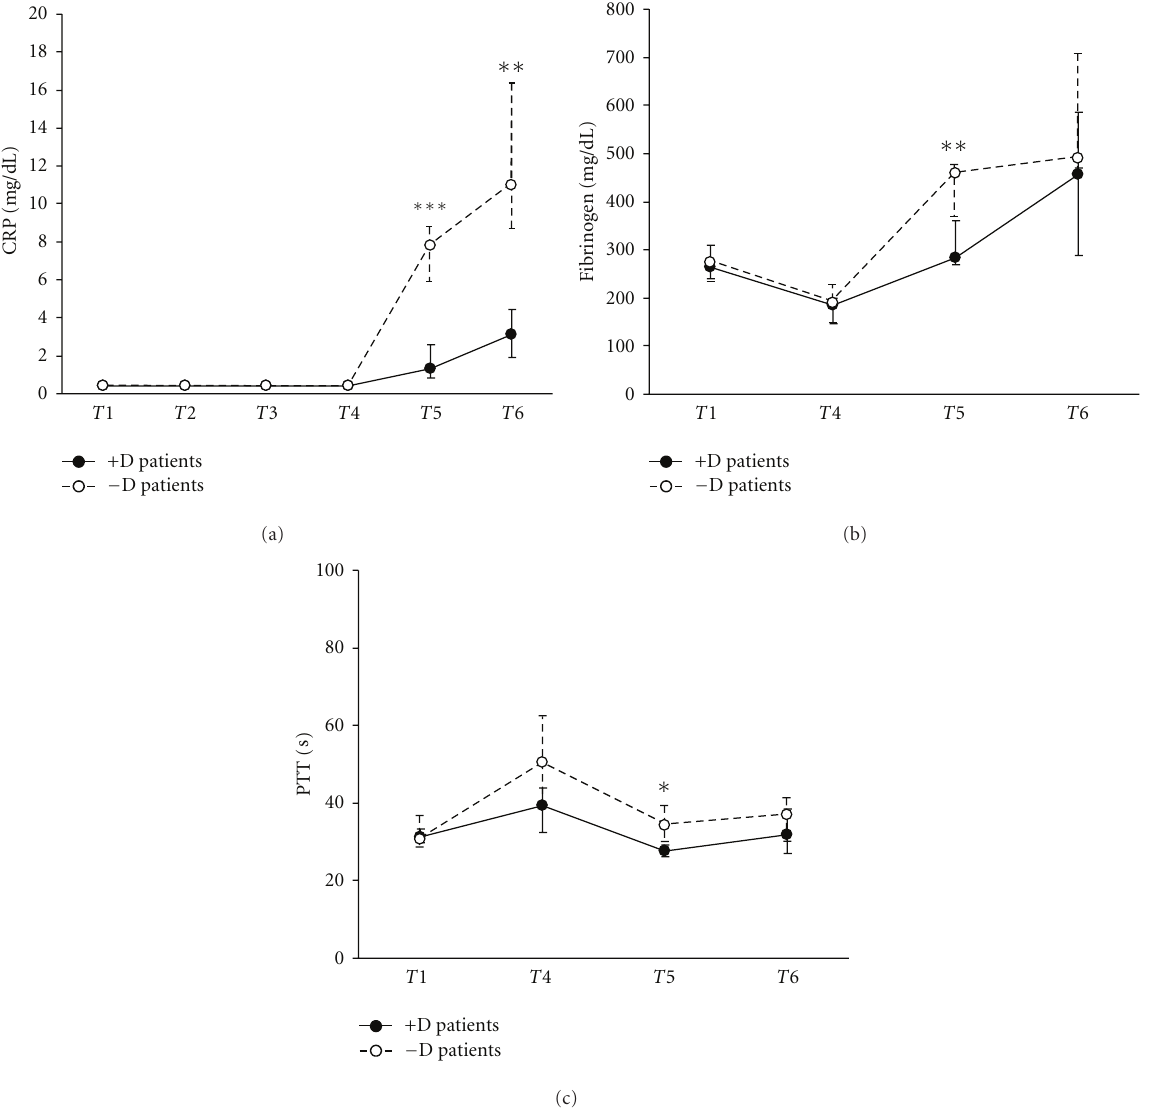
Figure 2: Plasma levels of CRP (a) and fibrinogen (b), and PTT values (c) in children undergoing CPB, either treated or untreated with dexamethasone. Values are expressed as medians and 1st and 3rd quartile. Time points are defined in Figure 1. ∗∗∗ P < 0 . 001; ∗∗ P < 0 . 01; ∗ P < 0 .